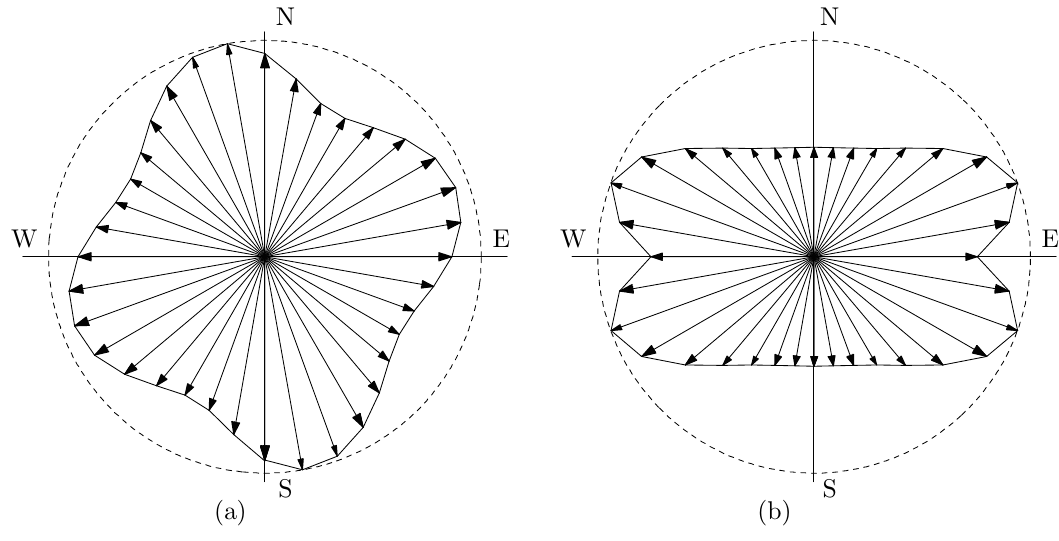
FIG. 8: Same as Fig. 7 but for a rectangular basin with larger aspect ratio. Here the basin dimension is Fig. 8. Same as Fig. 7, but for a rectangular basin with larger aspect ratio. Here, the basin dimension is 60km × 5km × 100m instead 60 km × 5 km × 100 m instead of the dimension of 65 km × 17 km × 100 m in Fig. 7. The dashed circles show of the dimension of 65km × 17km × 100m in Fig. 7. The dashed circles show the maximum value of the total kinetic energy, which is the maximum value of the total kinetic energy, which is 9 . 71 × 10 8 N m for the case with consideration of 9 . 71 × 10 8 Nm for the case with consideration of the Coriolis force (a) , but 8 . 57 × 10 9 Nm for the case without the Coriolis effect (b) . the Coriolis force (a), but 8 . 57 × 10 9 N m for the case without the Coriolis effect (b). tion. The kinetic energy attains its maximum for longitu- southeast wind. This loss of symmetry is due to the effect of dinal, western wind, while for a transverse southern wind, the Coriolis force, which can be demonstrated by means of repeating the computations, but under the neglect of the Cori- the kinetic energy is minimum, although the maximum and the minimum differ from each other only by approximately olis force. The analogous polar diagram of the total kinetic 15%. As expected, the dependence of the kinetic energy on energy, without consideration of the Coriolis force, is dis- the wind direction is anti-symmetric about the E-W or S-N played in Fig. 7b. In this case, the dependence of the kinetic axis. It is also seen that the kinetic energy subject to south- energy on the wind direction is symmetric about the E-W or S-N axes. When the Coriolis force is ignored, the west or northeast wind is larger than that for northwest or